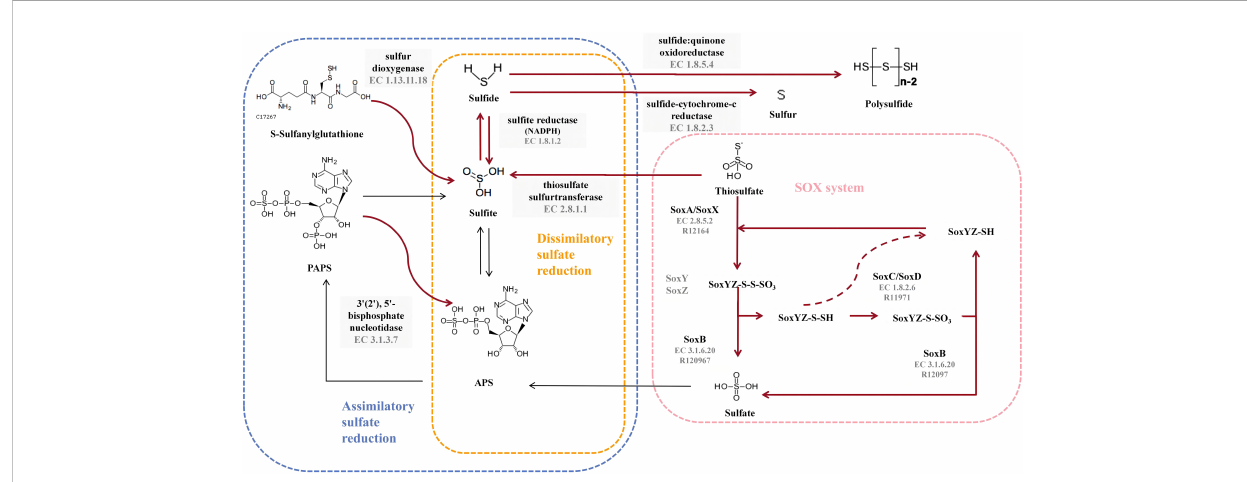
FIGURE 4 Diagram of the sulfur metabolic pathway. The pink blocks indicate SOX pathway-related enzymes, and the gray blocks indicate enzymes owned by strain 6S2-11 T that are not related to SOX but are related to sulfur metabolism. The red bolded arrows indicate pathways available to strain 6S2-11 T